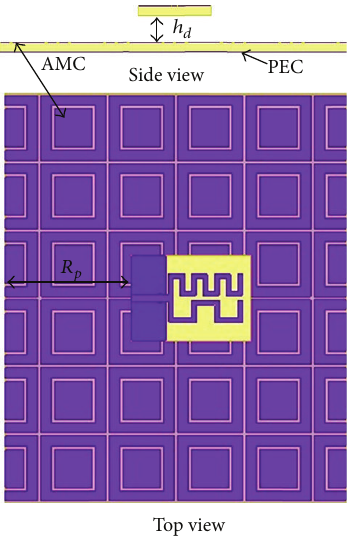
Figure 9: Configuration of antenna with an AMC reflector.